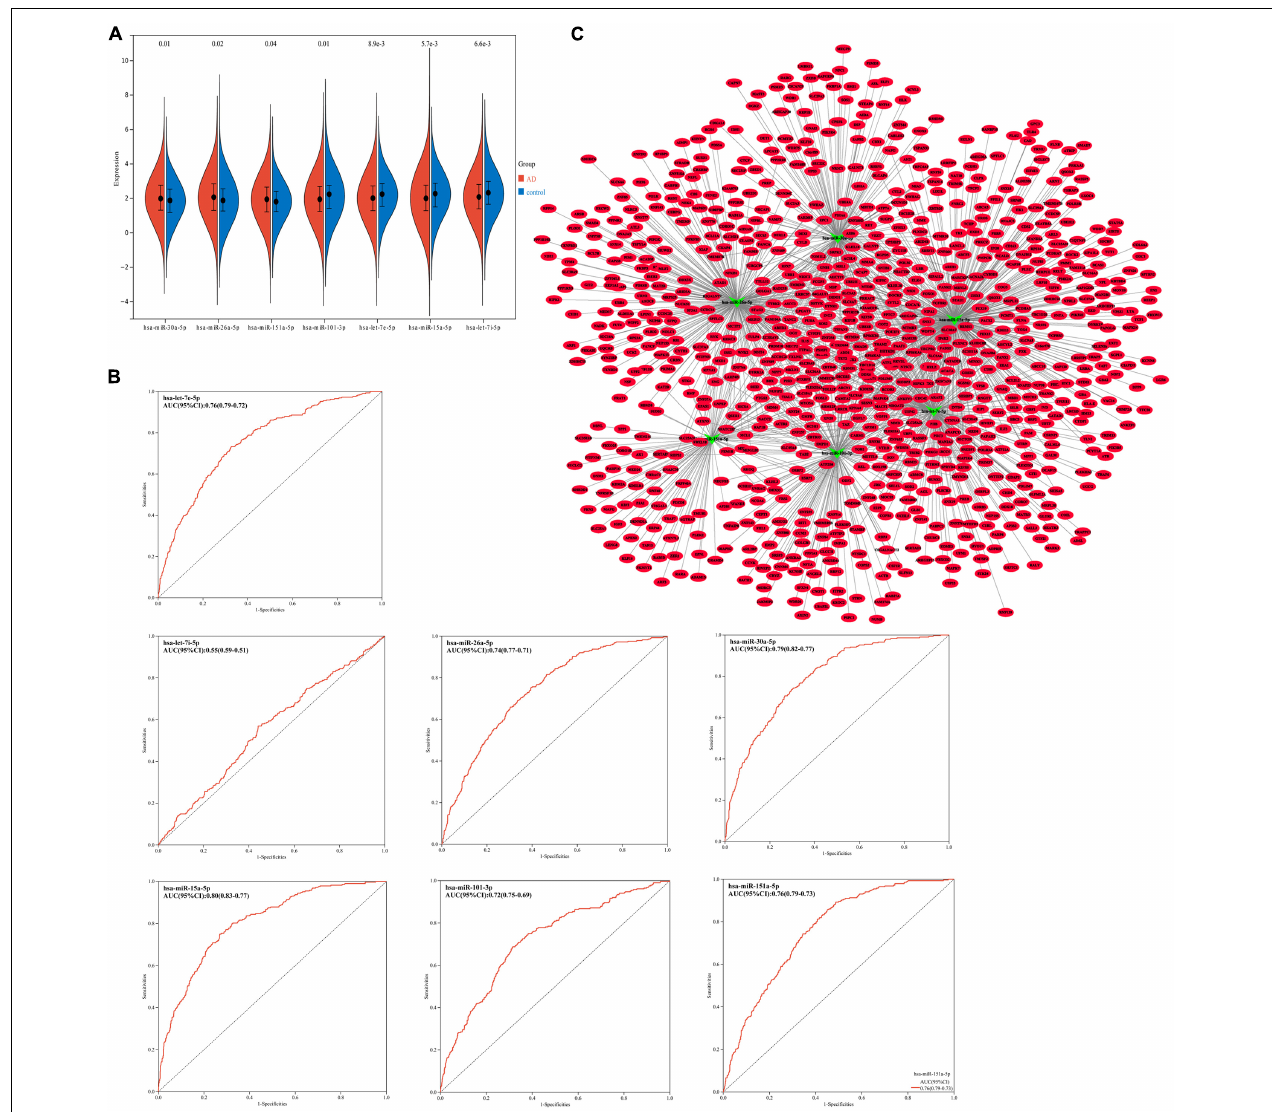
FIGURE 3 | (A) Expression trends of hsa-miR-30a-5p, hsa-miR-26a-5p, hsa-miR-151a-5p, hsa-miR-101-3p, hsa-let-7e-5p, hsa-miR-15a-5p and hsa-let-7i-5p in GSE120584. (B) Receiver operator characteristic curve (ROC) analysis of hsa-miR-30a-5p, hsa-miR-26a-5p, hsa-miR-151a-5p, hsa-miR-101-3p, hsa-let-7e-5p, hsa-miR-15a-5p, and hsa-let-7i-5p base on GSE120584 dataset. AUC, Area Under the Curve. (C) miRNA–mRNA regulatory network. The green triangle represents miRNA and the red oval represents